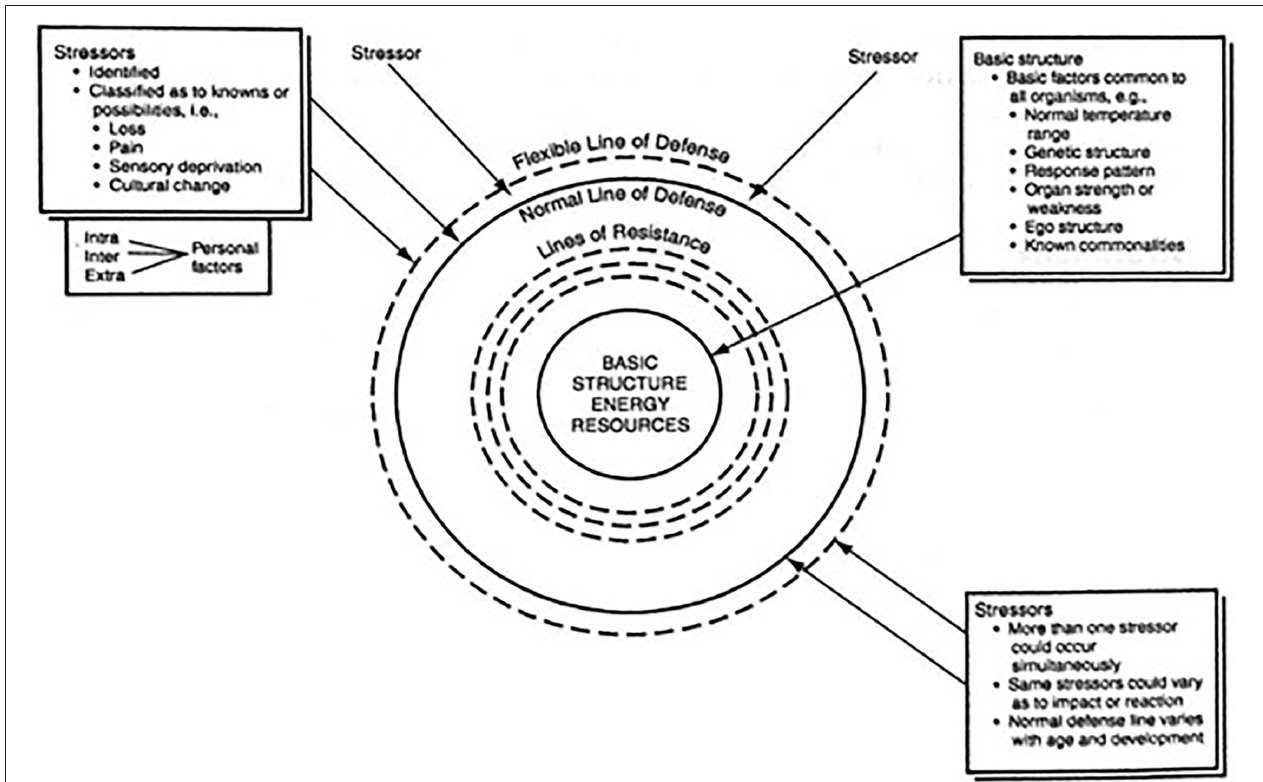
FIGURE 1 | Essential parts of the NSM used for the syntheses of results. Reprinted from Neuman and Fawcett (21). Physiological, psychological, sociocultural, developmental, and spiritual variables occur and are considered simultaneously in each client concentric